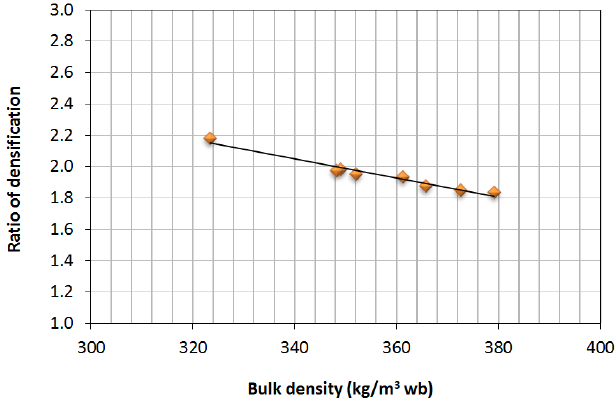
Figure 6. Comparison between bulk density and ratio of